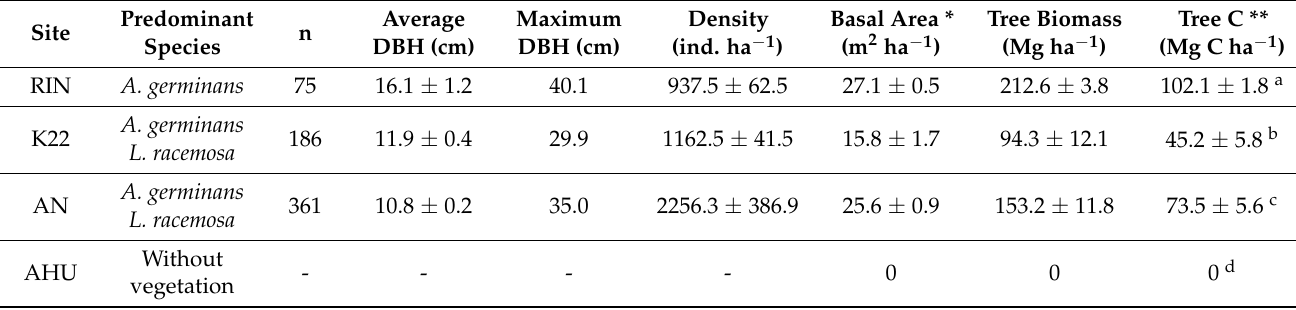
Table 1. Mangrove tree structure, biomass, and carbon (average ± SE). n: number of trees measured, DBH: diameter at breast height, C: carbon. Predominant Site